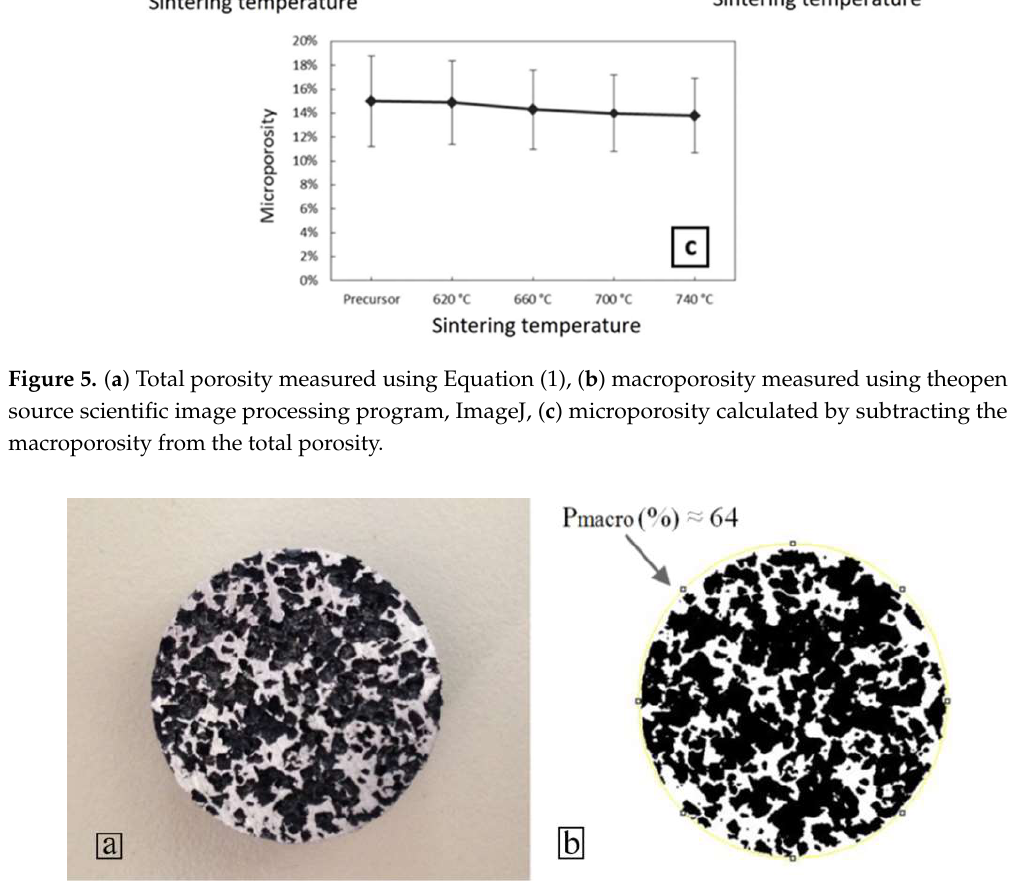
Figure 6. ( a ) Macrograph of a processed aluminum foam cross-section (at mid-height), ( b ) binary image of the porous structure (obtained by ImageJ).